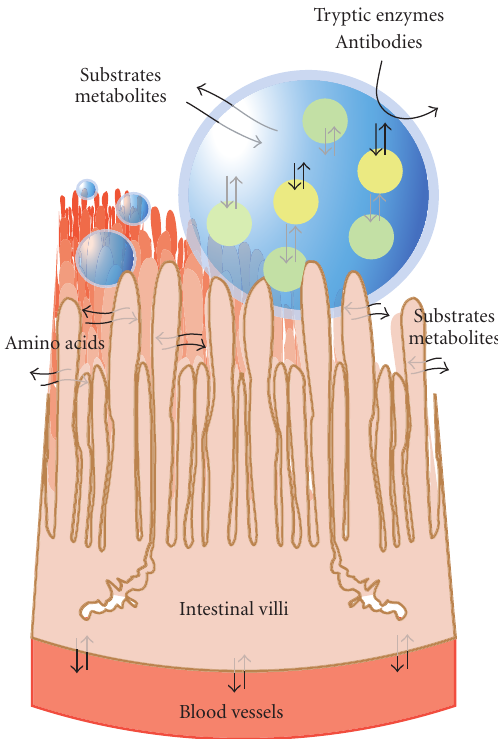
Figure 1. The principle of orally administered artificial cells containing bacterial cells for therapy. The semipermeable mem- brane excludes antibodies, tryptic enzymes, and other external materials but allows smaller molecules (amino acids, bile acids, ammonia, gasses, etc) to enter and be acted on by the enclosed microorganisms. Also, small molecules (including some pep- tides) produced by the enclosed bacterial cells can be designed to di ff use out into the body for